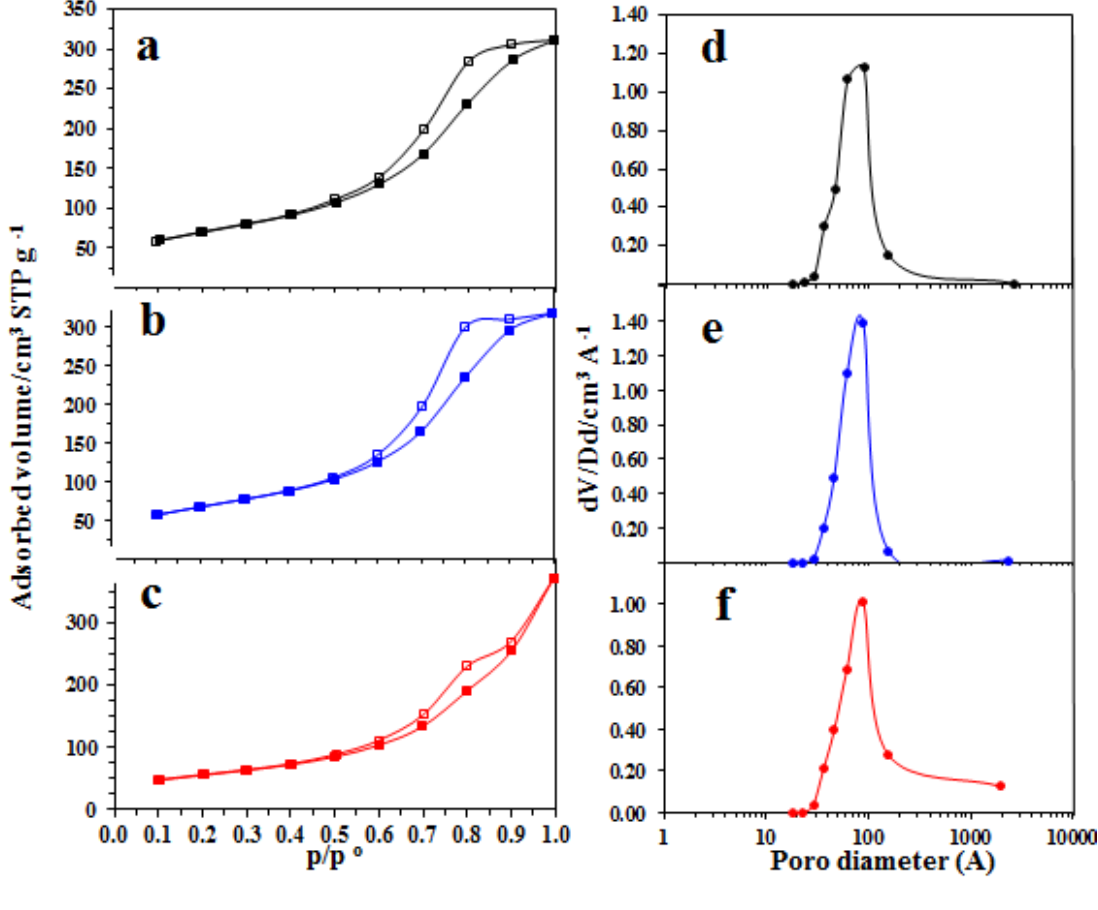
Figure 8. N adsorption/desorption isotherms at 77 K for ( a ) A; ( b ) AFSG and ( c ) AFI; 2 pore size distribution (PSD) using the Barrett-Joyner-Halenda (BJH) model for the desorption isotherms for ( d ) A; ( e ) AFSG and ( f )